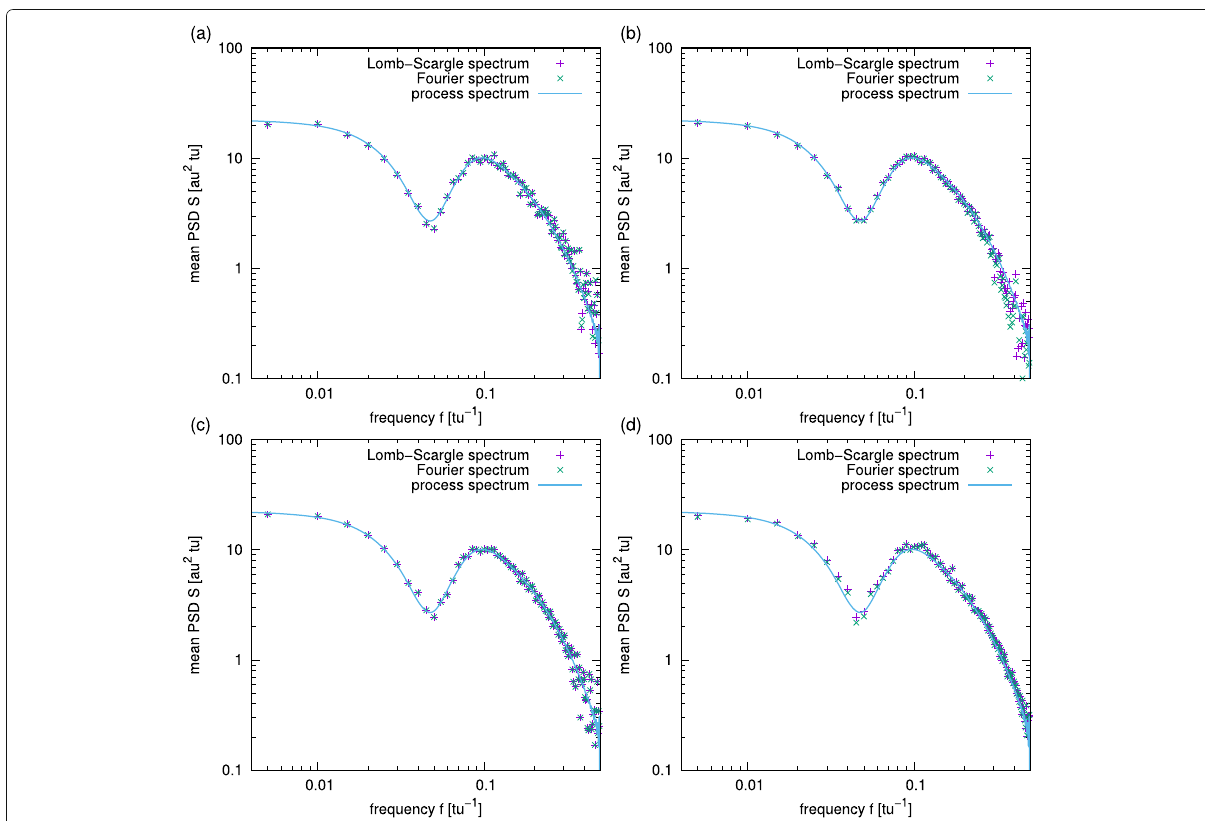
Fig. 5 Mean of the power spectral density with correction factors derived theoretically from the sampling models from 1000 signals. a Ideal random and independent samples from continuous time with a continuous distribution of sampling intervals, b random samples from continuous time with a continuous distribution of sampling intervals with processor dead time, c independent outliers in equidistant time with a discrete distribution of sampling intervals, and d correlated data gaps in equidistant time with a discrete distribution of sampling intervals (au, amplitude unit; tu, time unit)